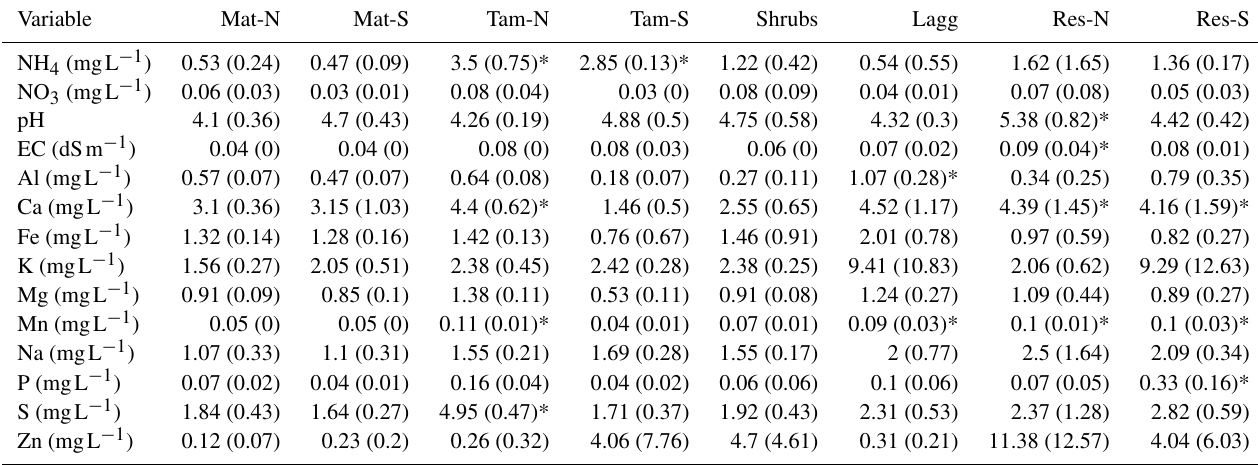
Table A2. Water chemistry of the pore water in the eight locations of the study. The means (SD) are averages of four measurements taken throughout the growing season of 2017. Asterisks indicate means that are significantly higher than at least one other